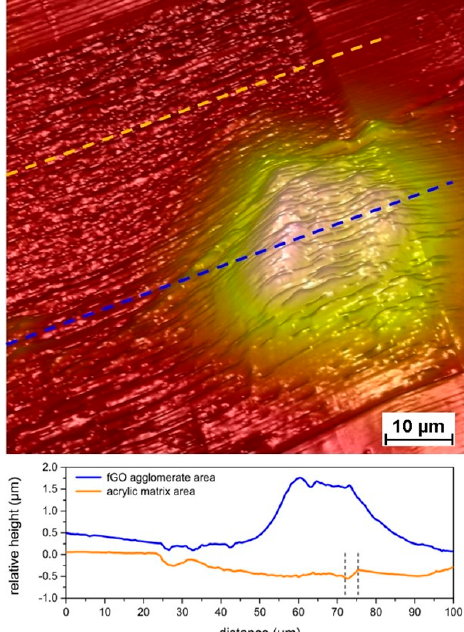
Figure 9. Detail of the abrasion front, with related profile analysis. The orange line represents the profile of an area of the acrylic matrix, while the blue line indicates the profile of an area with agglomerates of fGO.